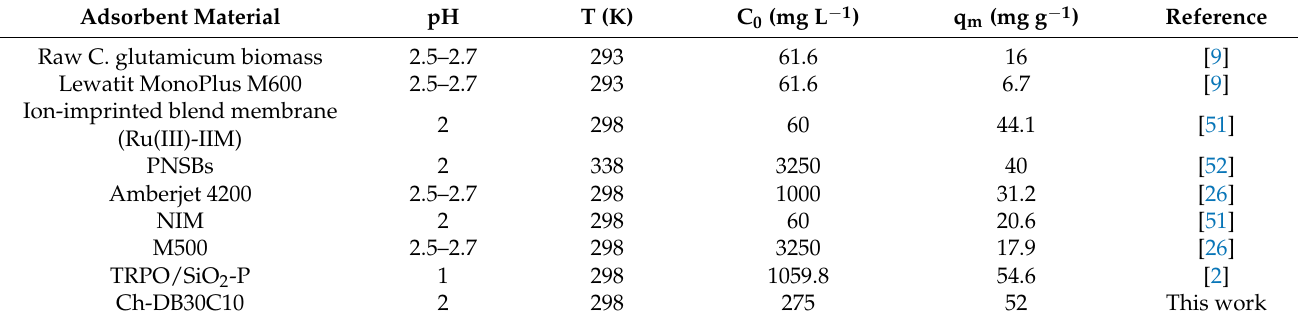
Table 5. Comparison of adsorption performance with other materials for Ru(III).